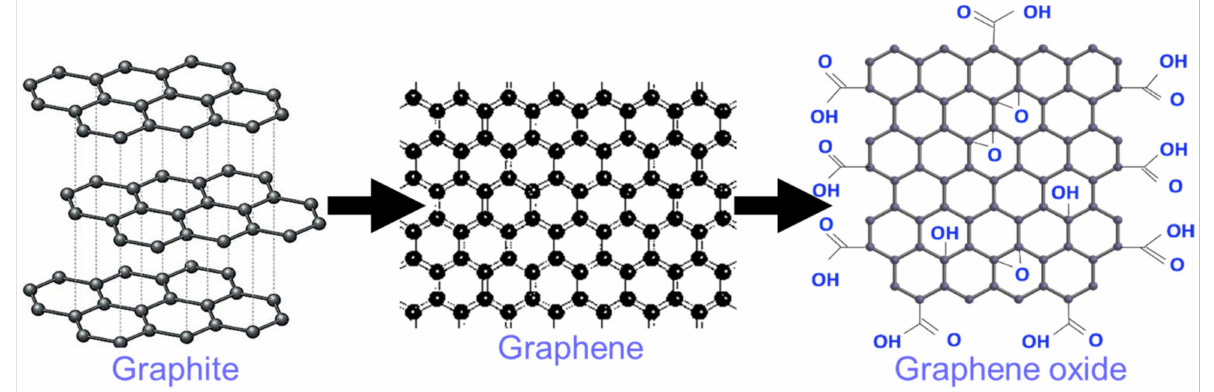
Figure 1. Graphite, graphene, and graphene